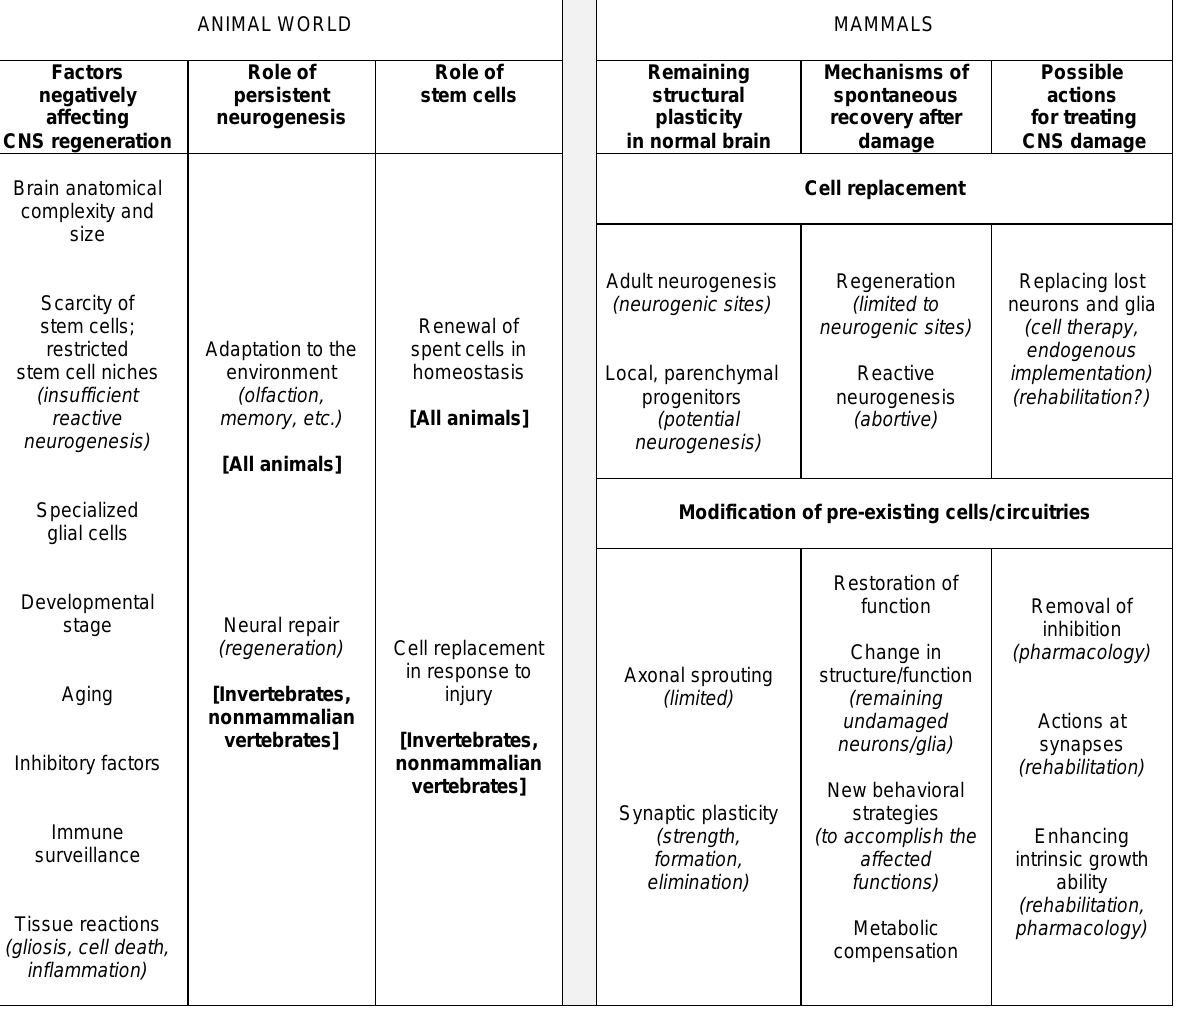
Variables involved in CNS Regeneration, Structural Plasticity, Repair, and